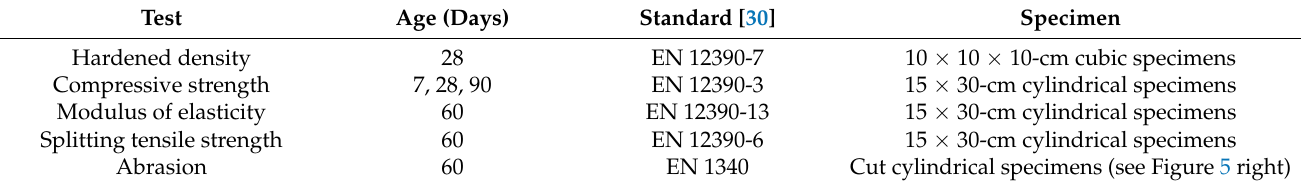
Table 4. Hardened tests.